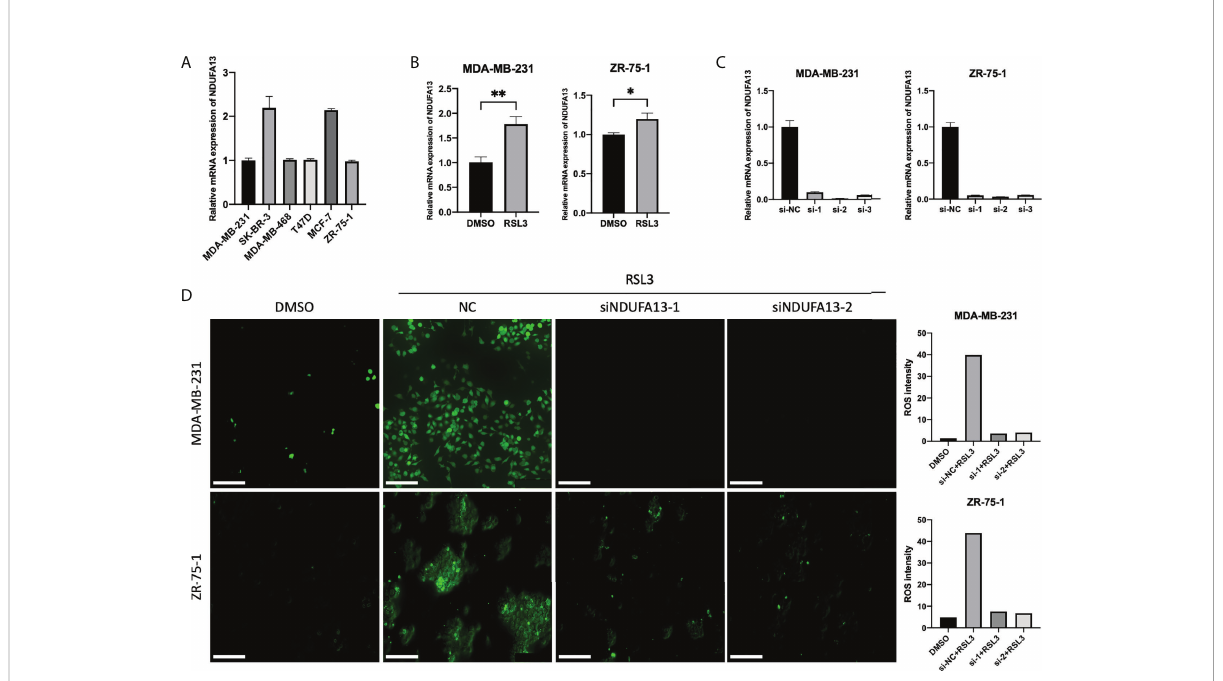
FIGURE 6 Validations of NDUFA13 as a biomarker for ferroptosis. (A) Expression of NDUFA13 in human breast cancer cell lines. (B) Expression of NDUFA13 mRNA in human breast cancer cell lines treated with DMSO or RSL3 (10 m M) for 24 h. (C) Ef fi ciency test of NDUFA13 siRNA knockdown (KD). (D) Intracellular level of reactive oxygen species (ROS) in breast cancer cells treating with DMSO or RSL3 (10 m M) followed by NDUFA13 KD. A two-sided P-value < 0.05 was considered signi fi cant. *P < 0.05; **P <